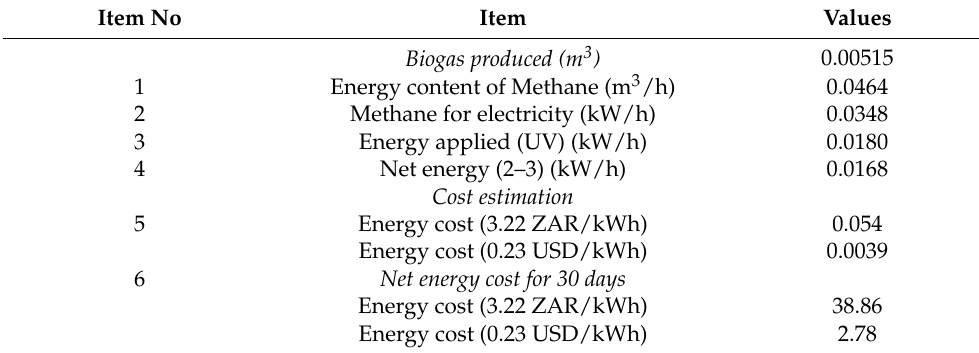
Table 3. The estimated energy cost of the BP system biogas produced from